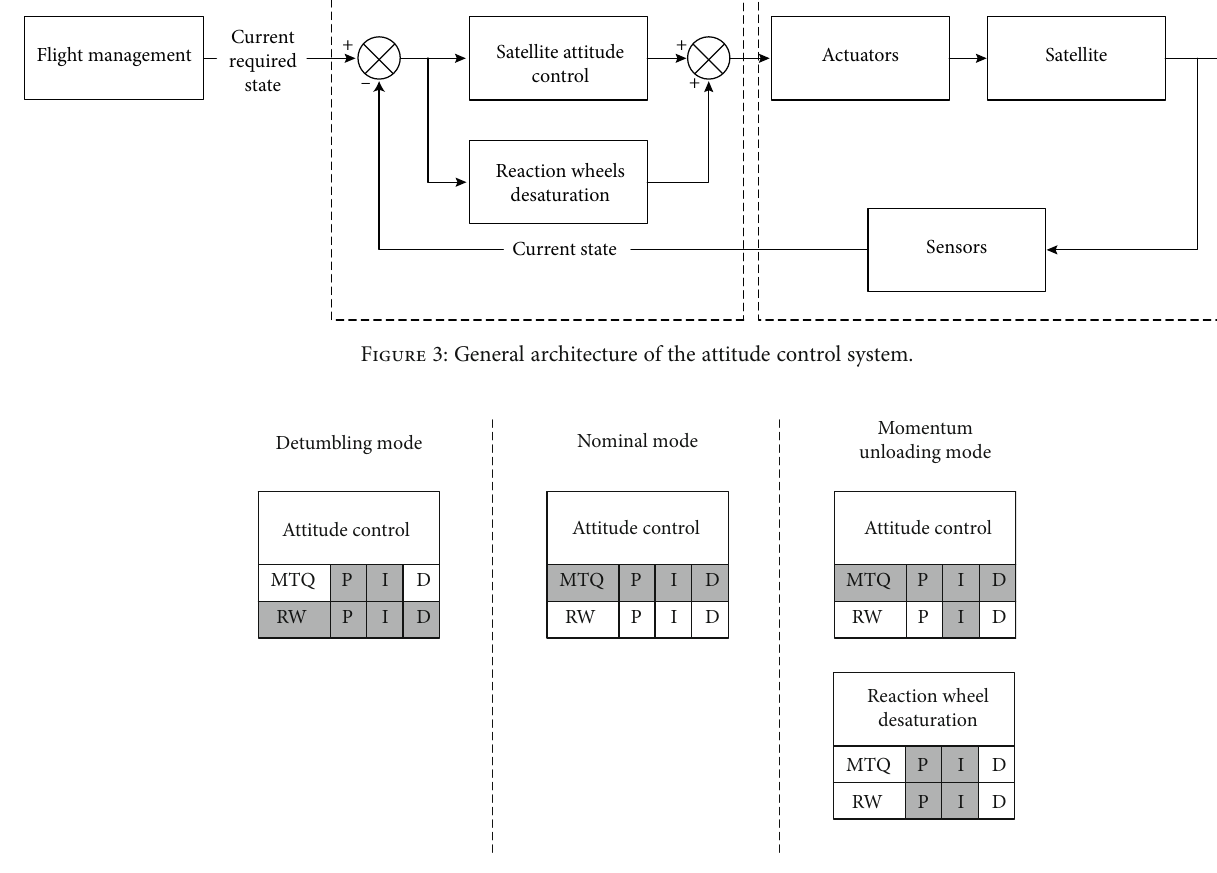
Figure 4: Attitude control system modes of